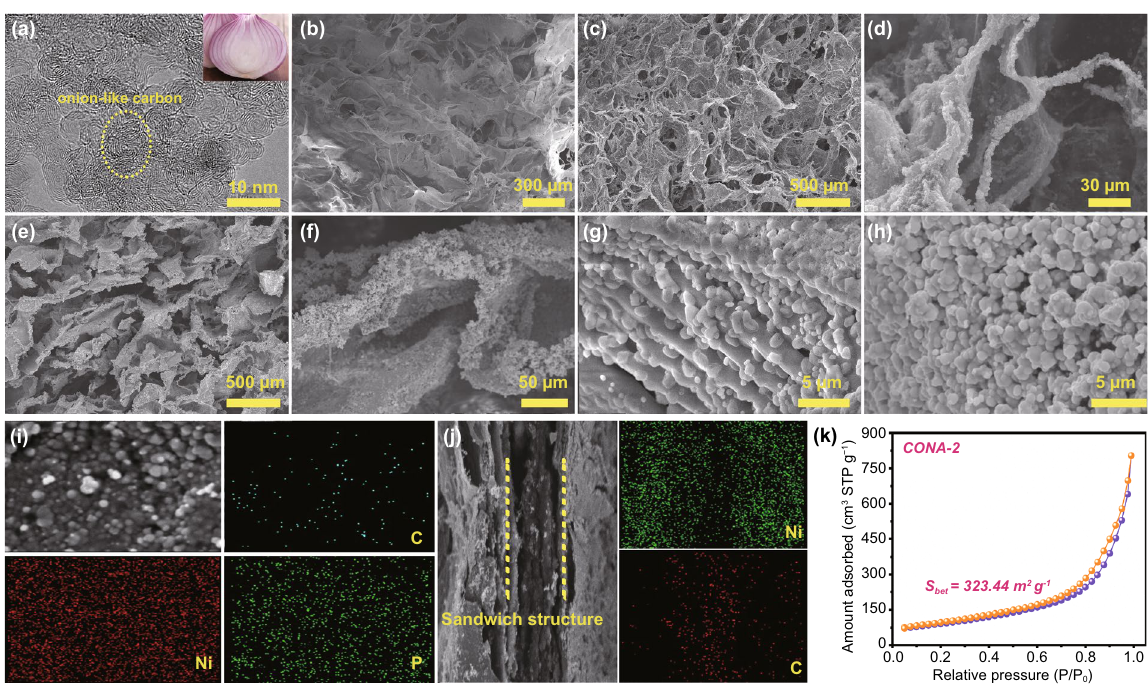
Fig. 3 a TEM images of CNO; SEM images of b CA, c‑d COA, and e–h CONA-2; EDS of C, Ni, and P elements of CONA-2 i and EDS of C and Ni elements of CONF-2 j ; k N 2 adsorption/desorption isotherms of Fig. 3k, the curves of CONA-2 display an IV-type isotherm and the calculated specific surface areas 323.44 m 2 g −1 .